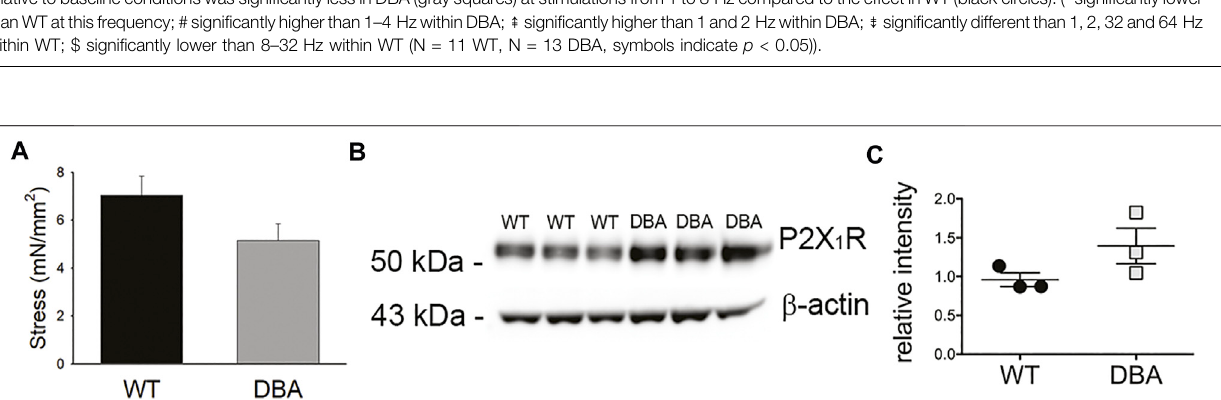
Frontiers in Physiology |